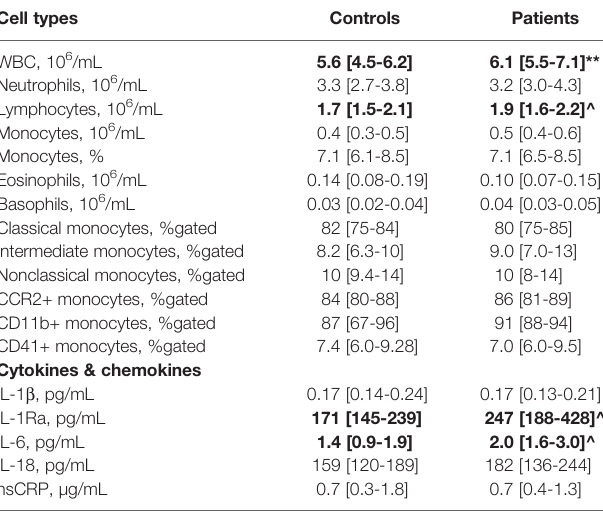
TABLE 2 | Circulating cell types and